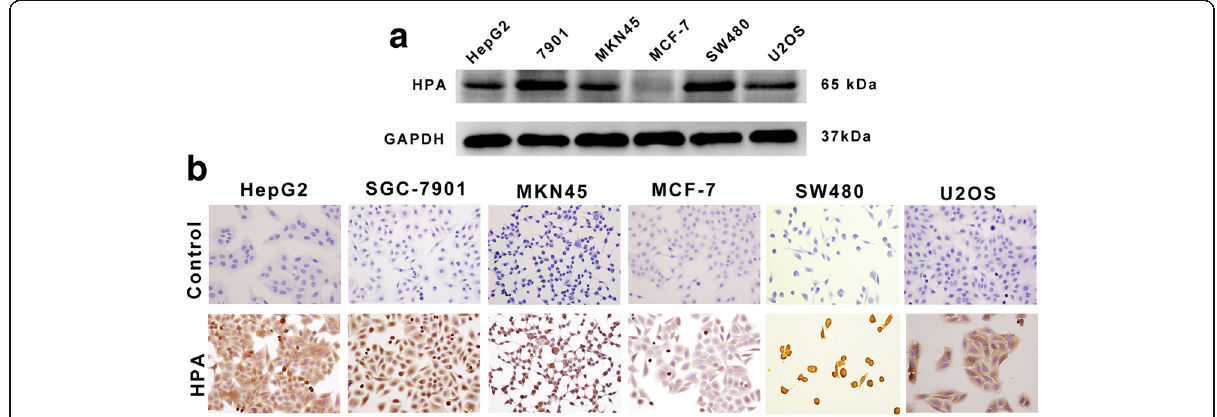
Fig. 1 Expression of Hpa proteins in various cell lines. a Western blot was used to detect HPA protein expression (65 kDa) in various tumor cell lines. Lane 1, HepG2; lane 2, SGC-7901; lane 3, MKN45; lane 4, MCF-7; lane 5, SW480; lane 5, U2OS. b Immunohistochemical analysis of HPA expression in HepG2, SGC-7901, MKN45, MCF-7, SW480, and U2OS cell